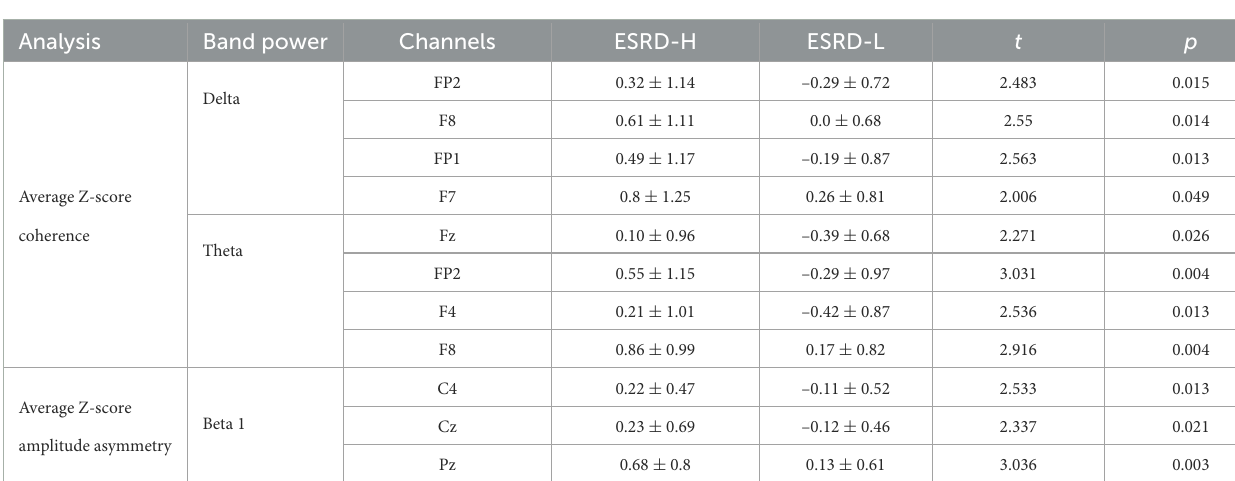
TABLE 4 The global mean comparison in the bivariate QEEG analysis.